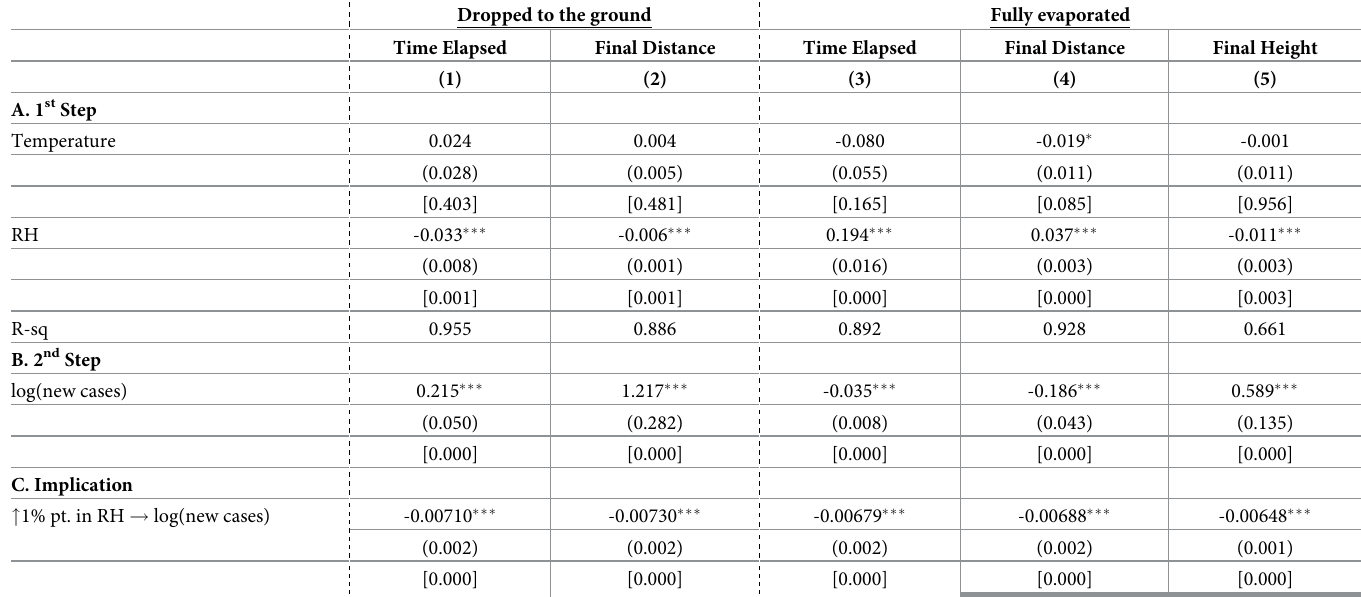
Table 2. Effect of droplet transport characteristics on newly infected